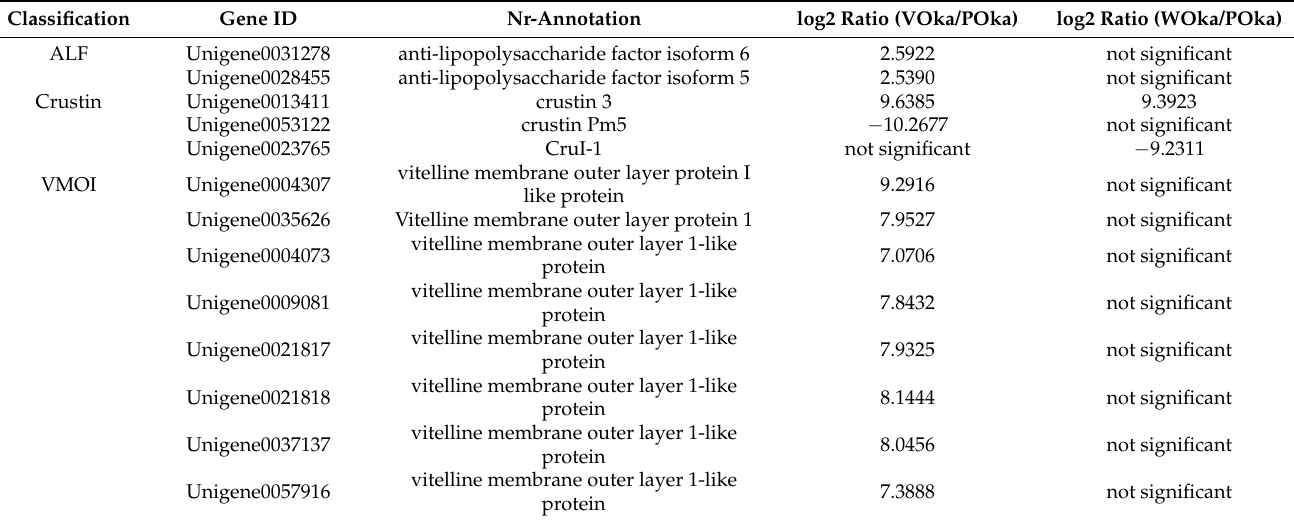
Table 5. DEGs related to immune effectors in the lymphoid organ after Vibrio or WSSV challenge.